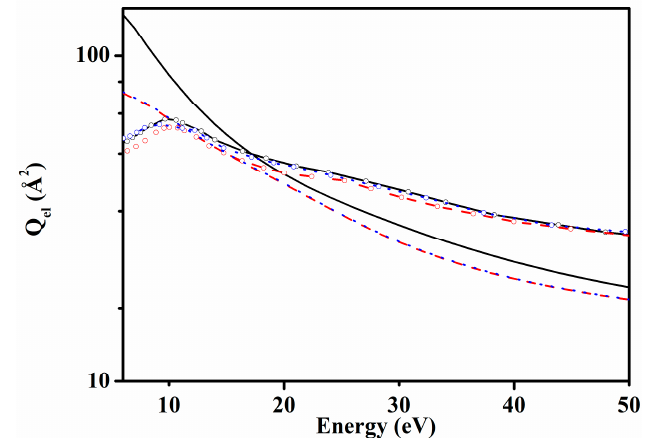
Figure 2. Solid lines (black) represent butan-2-ol, dashed lines (red) represent 2-methylpropan-1-ol and dotted lines (blue) represent 2-methylpropan-2-ol results. Lines (only) show present results and lines with open circles are results from Bettega et al.